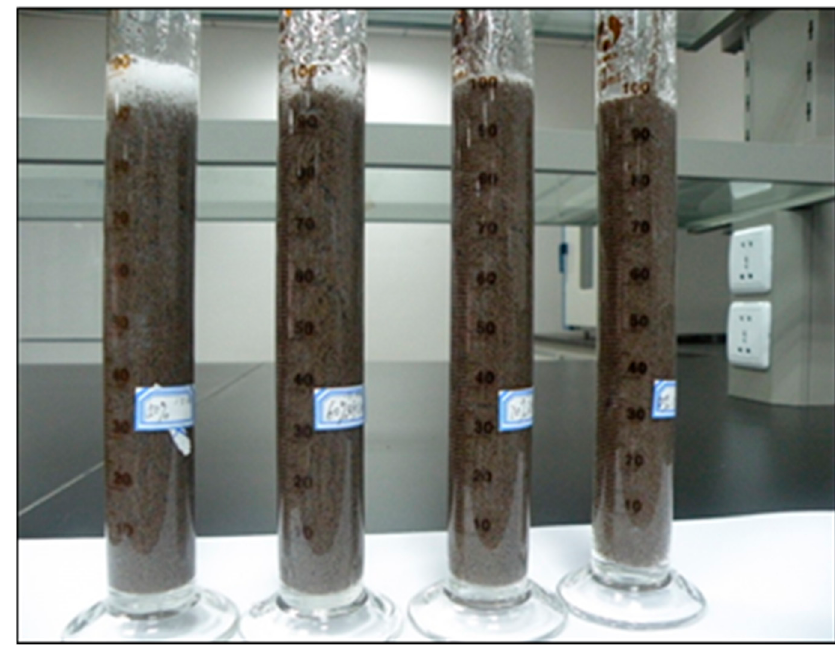
Figure 19. The static suspended sand test results of gel fracturing fluid.